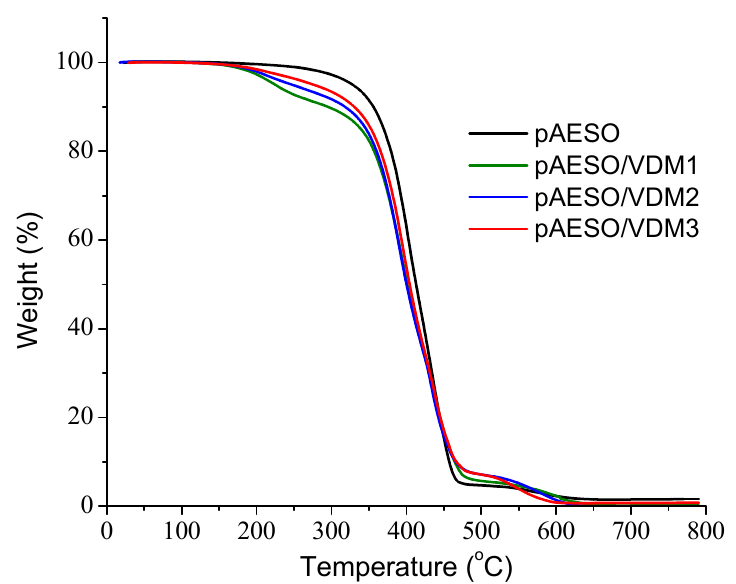
Figure 6. The thermogravimetric curves of the polymers pAESO and the polymer series pAESO/VDM.